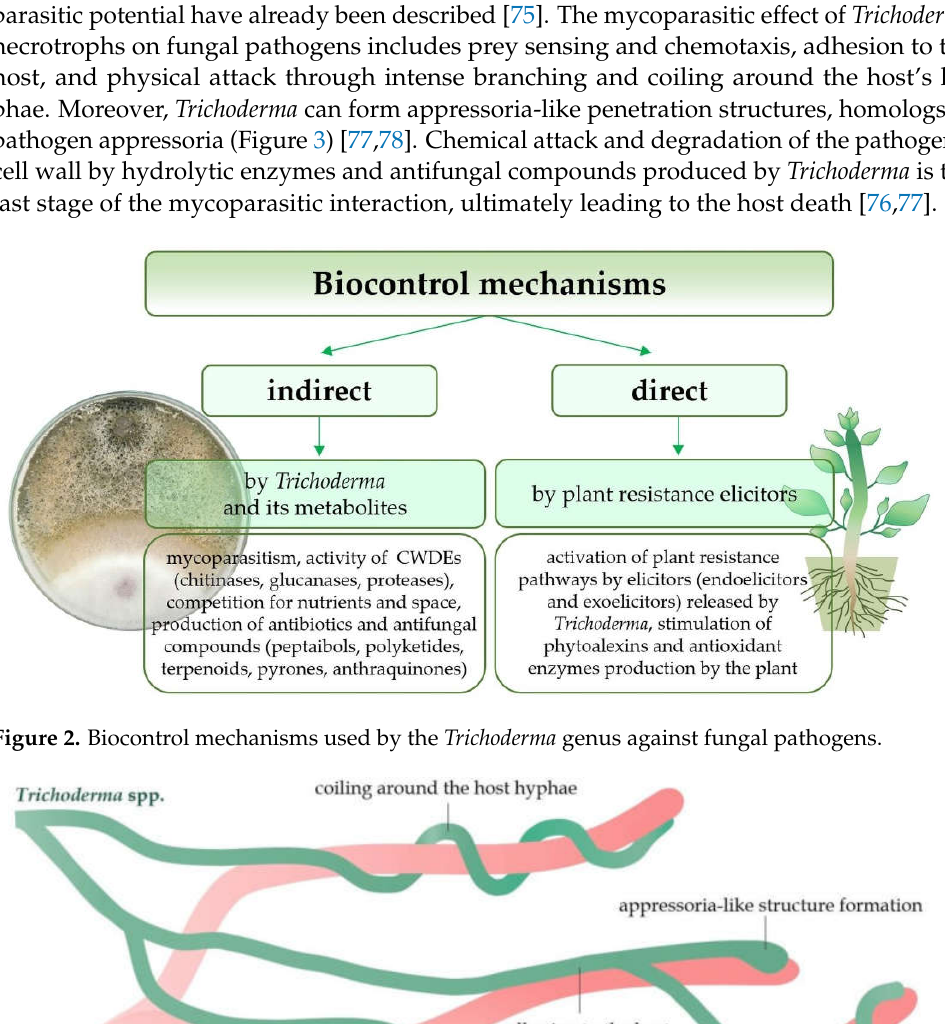
Figure 3. A schematic mycoparasitic interaction of the Trichoderma hyphae with the hyphae of fungal pathogens.